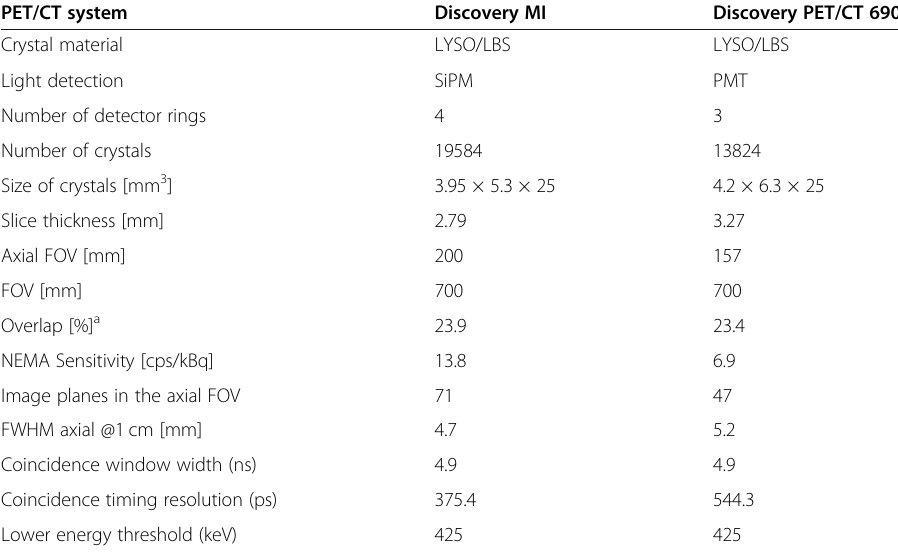
Table 1 Characteristics of the Discovery MI and Discovery 690 scanners PET/CT